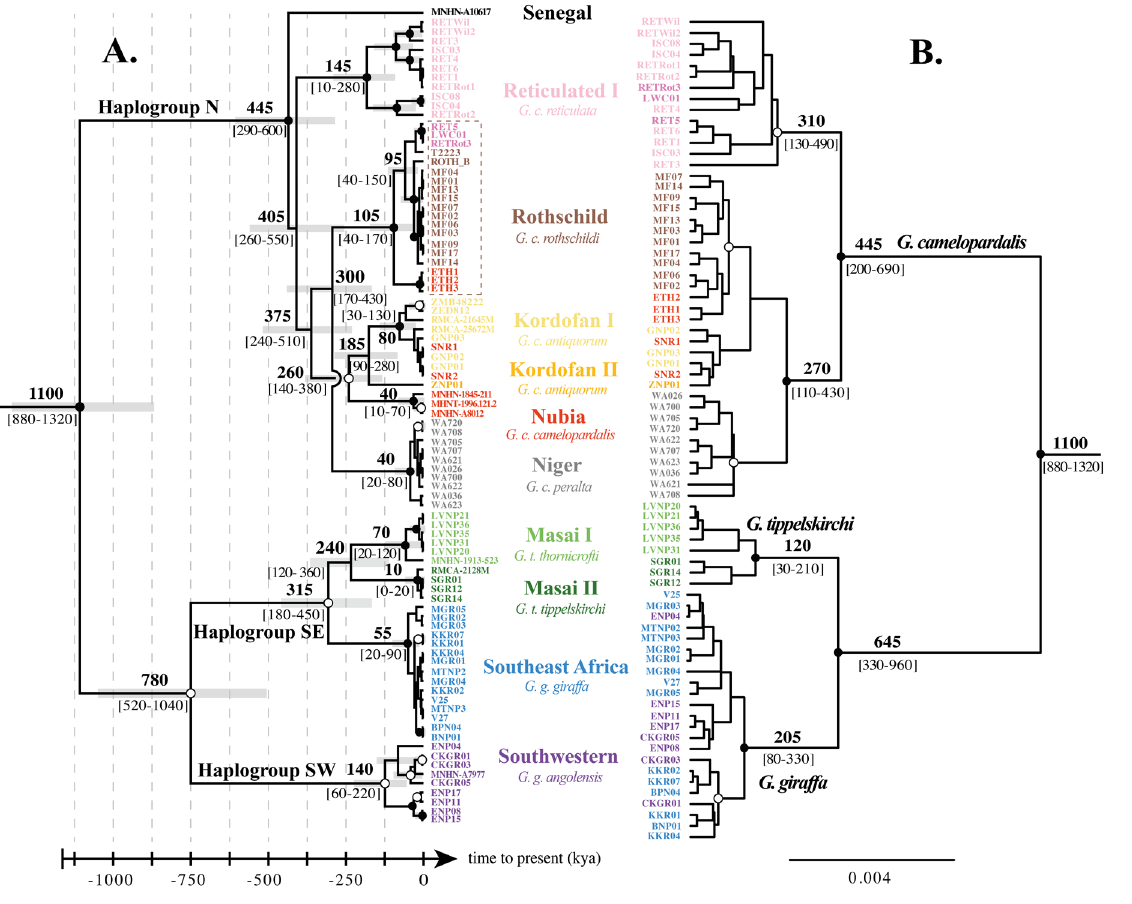
Fig. 4. Comparison of mitochondrial and nuclear divergence time estimates. A . Chronogram inferred from the mtDNA dataset using BEAST ver. 1.8.4 (Drummond et al. 2012). The mean divergence times are reported on the nodes, and the horizontal grey bars show 95% confidence intervals. B . Phylogram reconstructed from the multispecies coalescent analysis of the nuDNA dataset using *BEAST ver. 2.4.8 (Bouckaert et al. 2014). Divergence times estimated in BEAST ver. 1.8.4 (Drummond et al. 2012) are reported on the nodes to allow comparison with the mtDNA chronogram ( Supplementary file 8 ). Nodes with a white circle were supported by PP ≥ 0.95, whereas nodes with a black circle were supported BEAST by both PP ≥ 0.95 and BP ≥ BEAST ML